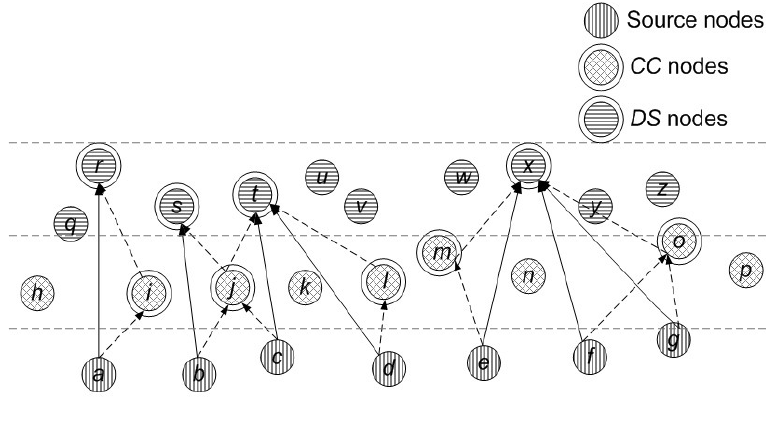
Figure 5. Selection of DS and CC nodes in a